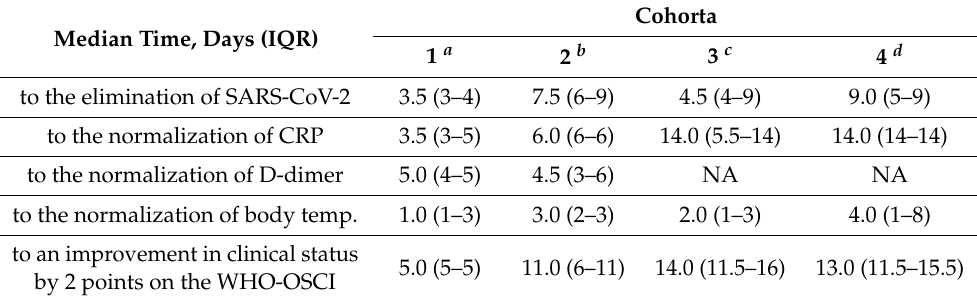
Table 2. Efficacy endpoints in the mice model of COVID-19.